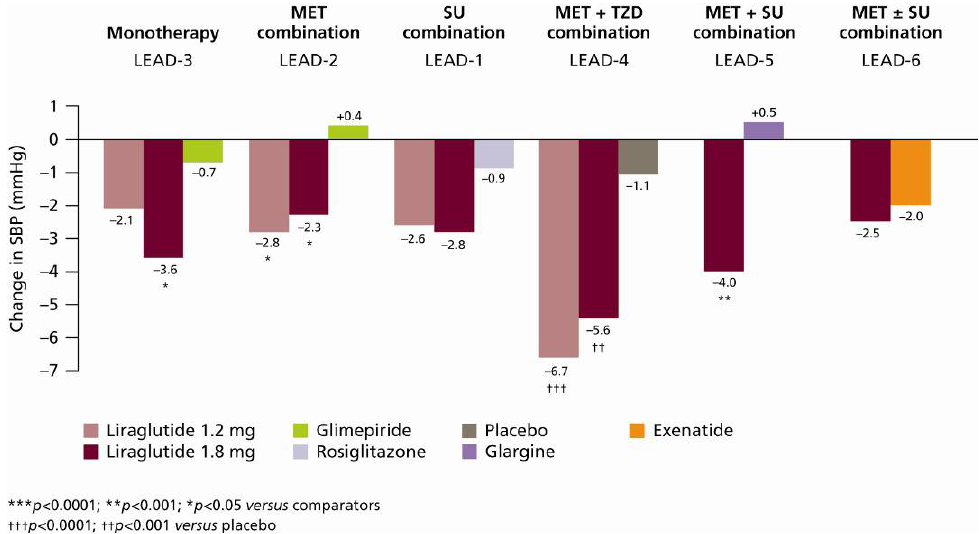
Figure 11. Change in SBP across LEAD-1–6